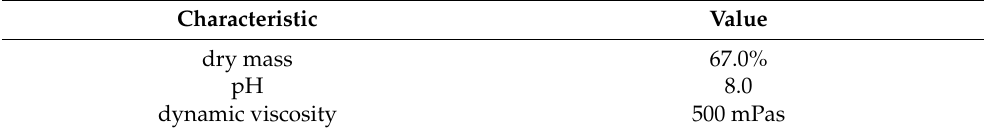
Table 2. Properties of UF resin (Silekol 123).